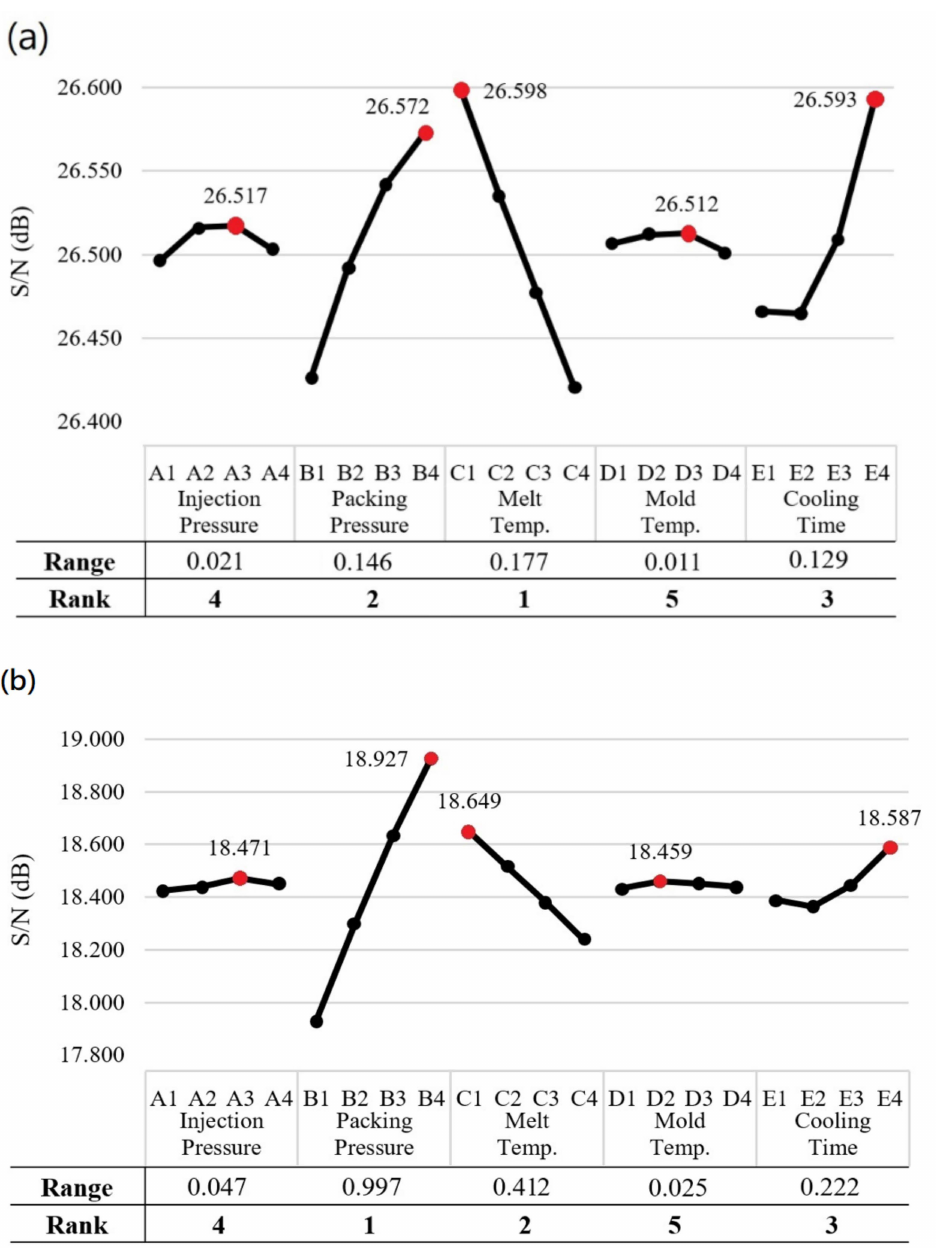
Figure 9. S/N response for ( a ) Overall roundness and ( b ) Overall concentricity. The effects of the melt temperature and cooling time mainly affect the geometric deformation of the injected part. Deformation is the most important factor that simultane- ously affects the optimization of both roundness and concentricity. Generally, the control factors affecting plastic deformation are temperature and cooling. The melt temperature can determine the difference between the surface compressive stress and the internal tensile stress of the injected part during the curing process. In addition, the cooling time is